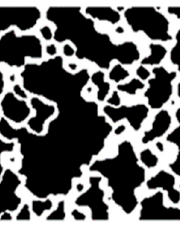
Figure 5. GRID01, constituted by squared pores, and a pore-throat to pore-body ratio of 2:1. The total number of pores is 64000. ( a ). Throats are 25 µm, and pores are 50 µm wide ( b ).